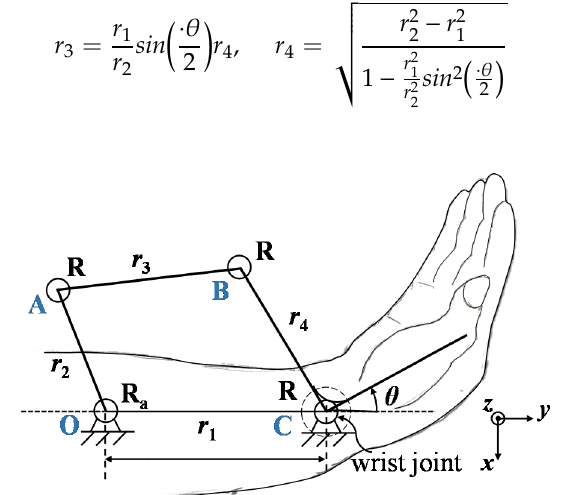
Figure 4. ( a ) Exoskeleton attached to the forearm; ( b ) Exoskeleton detached from the forearm.